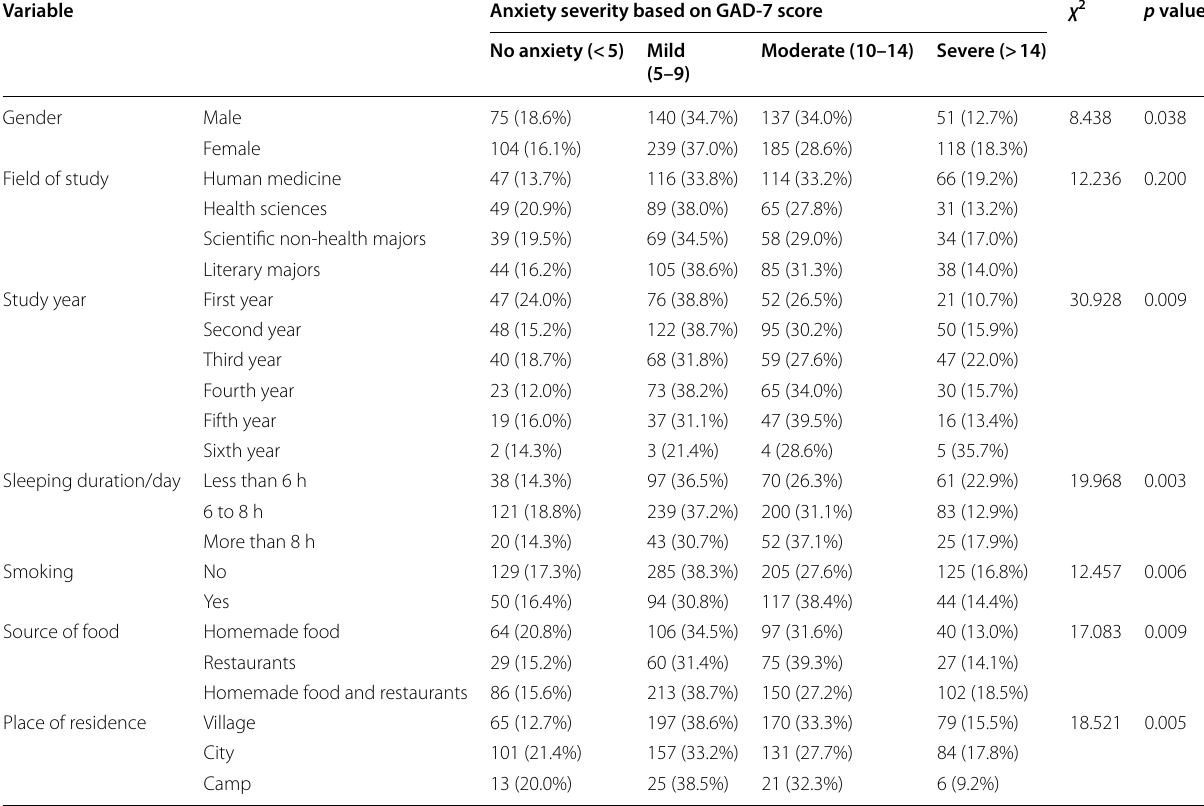
Table 4 The association between anxiety severity and sample characteristics ( n